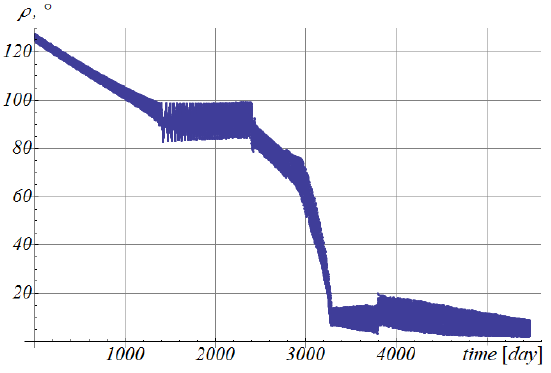
Figure 9. Evolution of angle ρ in scenario 3.